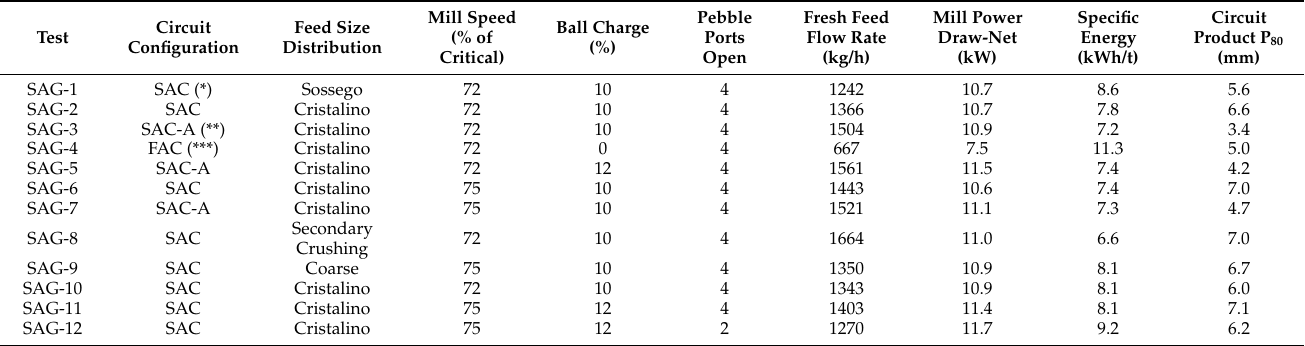
Table 2. Cristalino AG/SAG milling pilot plant campaign